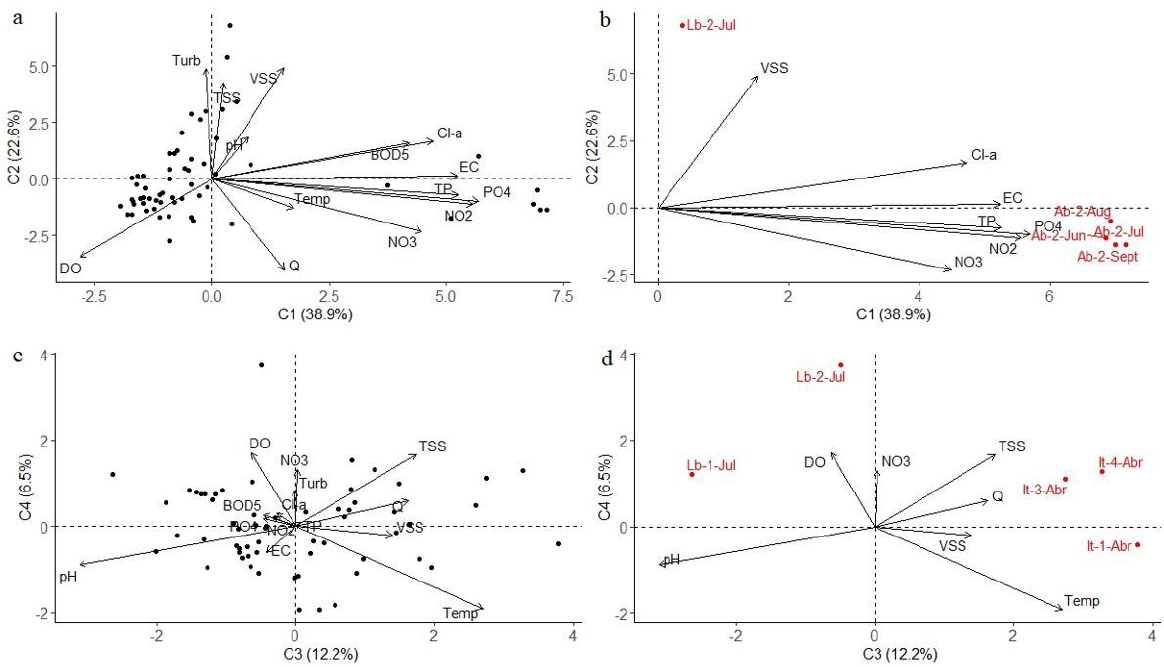
Figure 6. PCA analysis for dry season data set showing the C1 and C2 (a); variables and sample points of C1 and C2 with higher contribution (b); variables of the C3 and C4 (c); variables and sample points of C3 and C4 with higher contribution